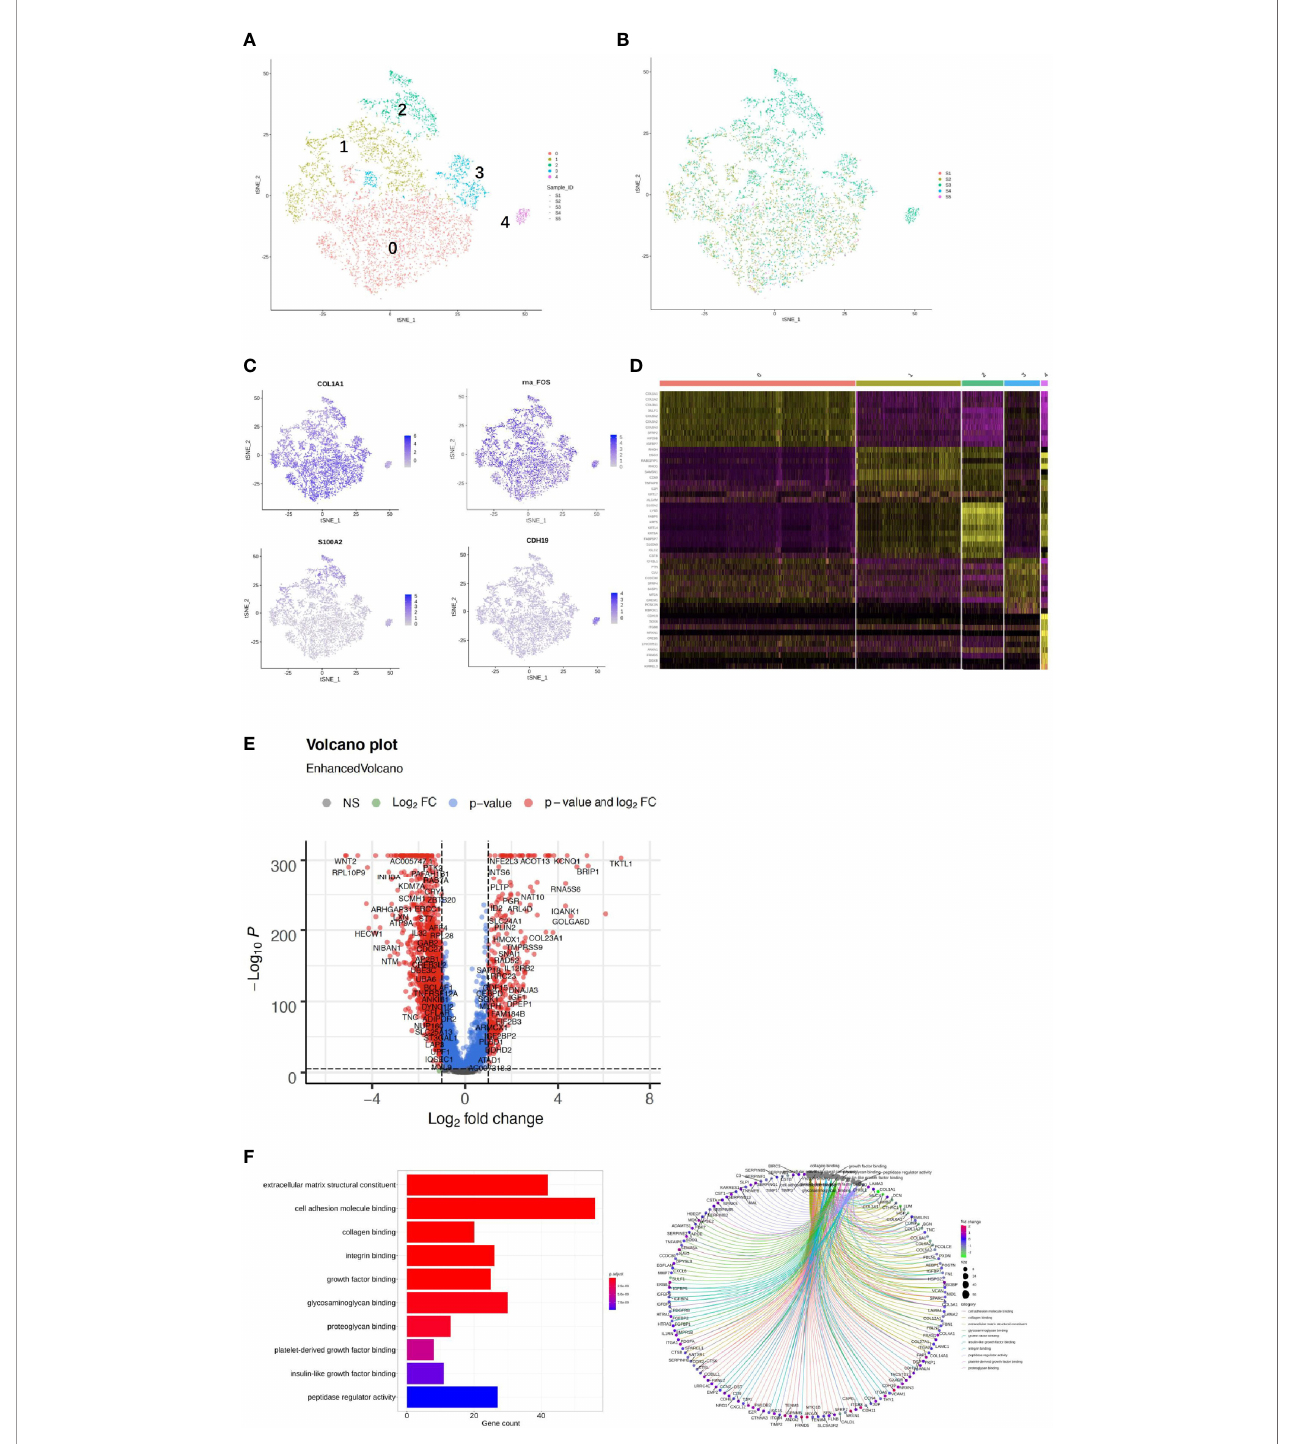
FIGURE 4 | Single-cell RNA sequencing (scRNA) pro fi les of fi broblast cell lineages. Reclustering of 8,329 fi broblast cells color-coded by (A) clusters and (B) sample origin (right). (C) t -Distributed stochastic neighbor embedding ( t -SNE) plot color-coded for marker gene expression (gray to white to blue) for COLIAI , FOS , S100A2 , and CDH19 . (D) Heatmap shows differentially expressed marker genes (rows) in fi ve clusters. Yellow and dark purple: high and low expression, respectively. (E) Volcano plot shows differentially expressed marker genes between cervicitis and cervical cancer samples. (F) Differences in pathway activities of cells between cluster 1 (C1), C2, C3, and